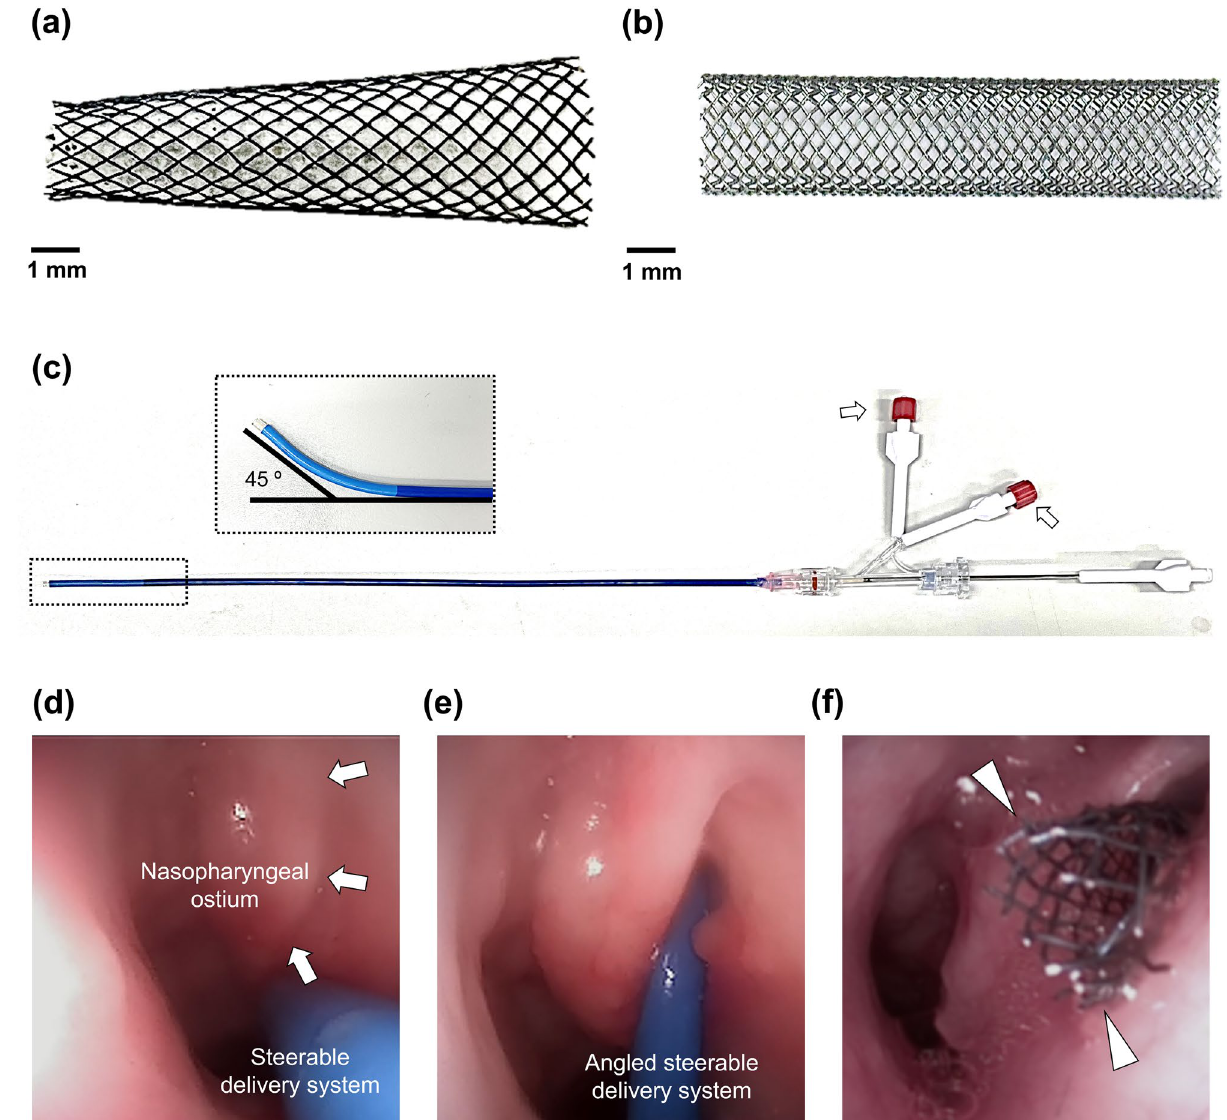
Figure 2. Self-expandable metallic stents (SEMSs) with the delivery system and the technical steps for stent placement into the porcine ET. Photographs showing ( a ) the tapered SEMS (T-SEMS) and ( b ) conventional SEMS (C-SEMS). ( c ) The steering control threads ( arrows ) were used to modulate the angle of the proximal end of the stent delivery system for easy access to ET orifice (maximum curved angle was 45°). ( d ) Endoscopic image showing the nasopharyngeal ostium ( arrows ) and inserted steerable delivery system. ( e ) The angled delivery system was inserted into the nasopharyngeal ostium. ( f ) The T-SEMS ( arrow heads ) was successfully placed into the